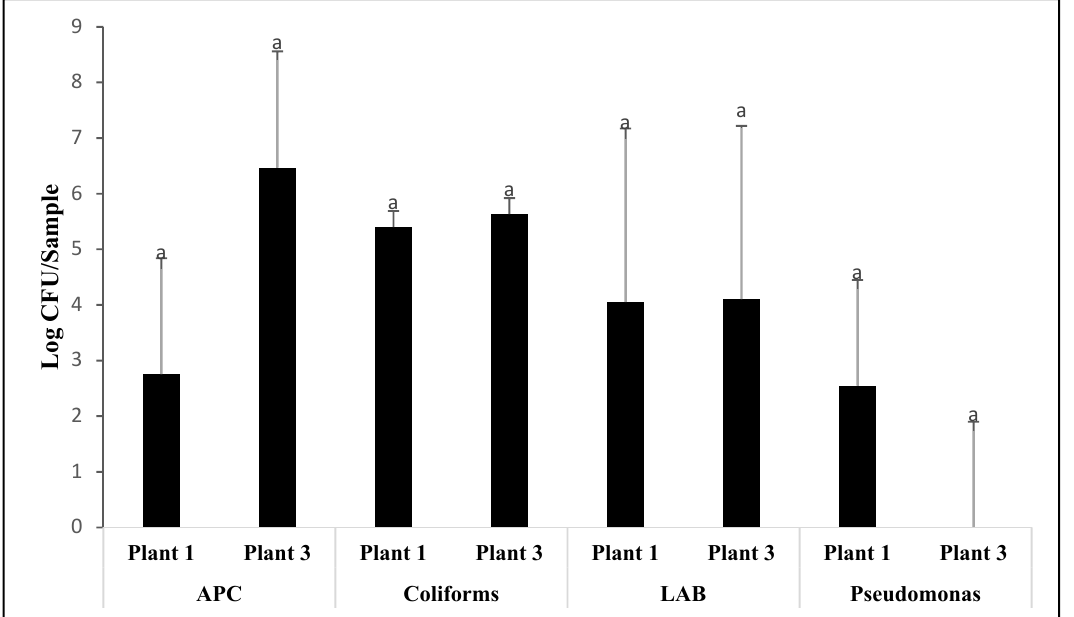
Figure 2. Aerobic plate count (APC), coliforms, lactic acid bacteria (LAB), and Pseudomonas contam- ination expressed as log CFU/sample, detected from MDM samples in processing plants 1 and 3 ( p = 0.174). Means with different letters differ statistically.